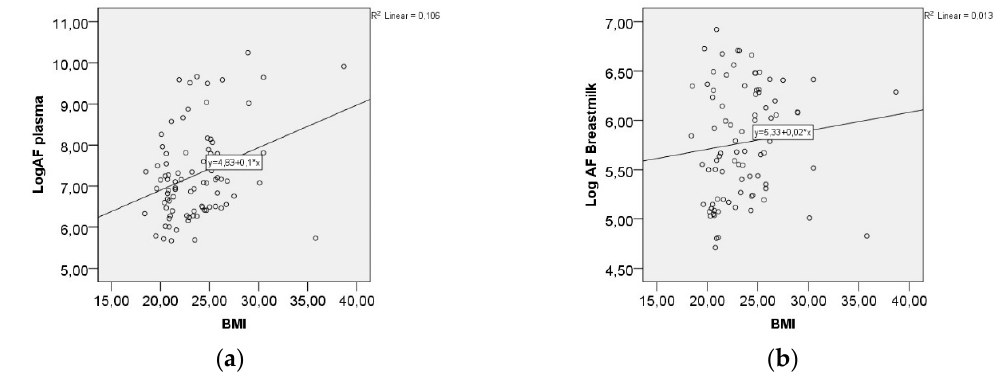
Figure 3. ( a ) AF-levels in plasma correlating to BMI, Spearman’s rho 0.252, p < 0.05; ( b ) AF-levels in breast milk in correlation to BMI, Spearman’s rho 0.193, p = 0.08.